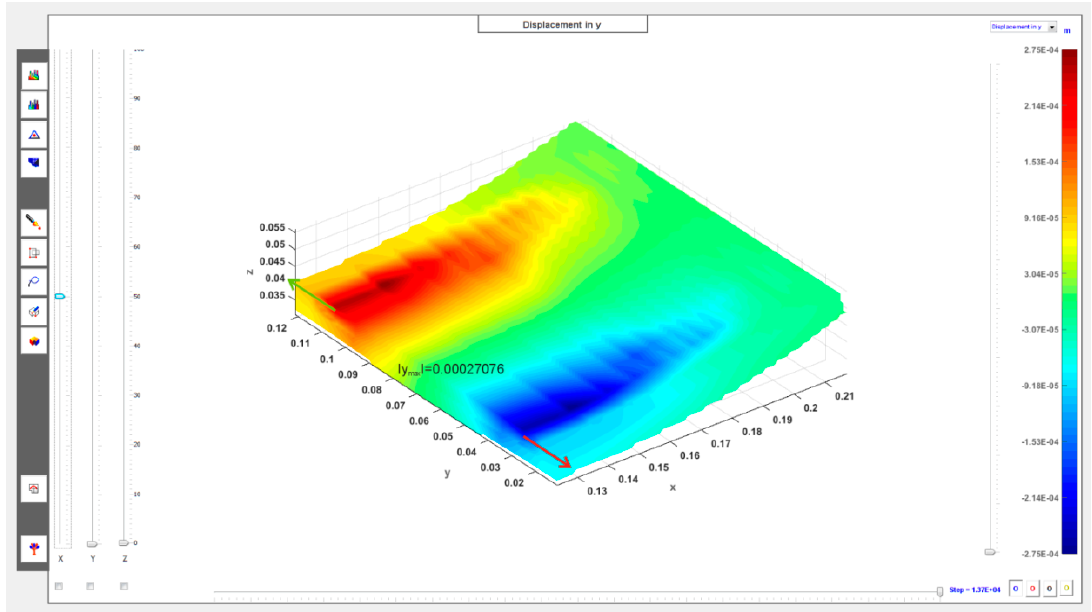
Figure A12. Displacements (in meters, middle section) in sand layer in parallel y direction to roller axis: h = 2.0 mm, p opt = 2.85 bar ( N = 1425 N).